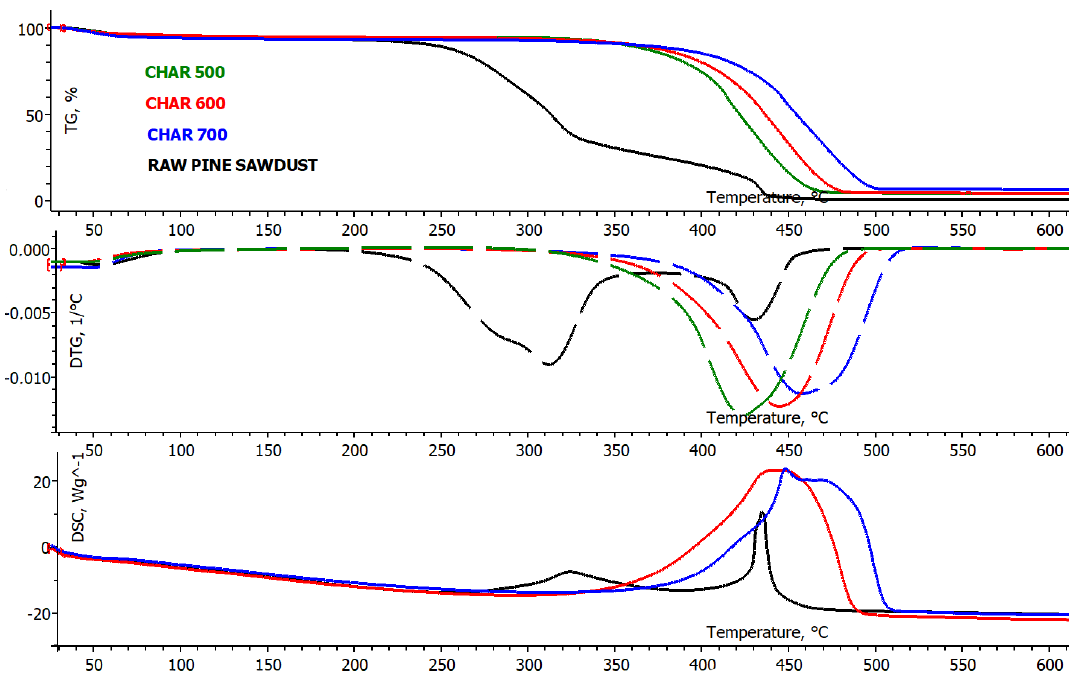
Figure 6. Thermogravimetric (TG), differential thermogravimetric (DTG) and differential scanning calorimetry (DSC) curves presenting combustion process of all obtained chars and raw material.